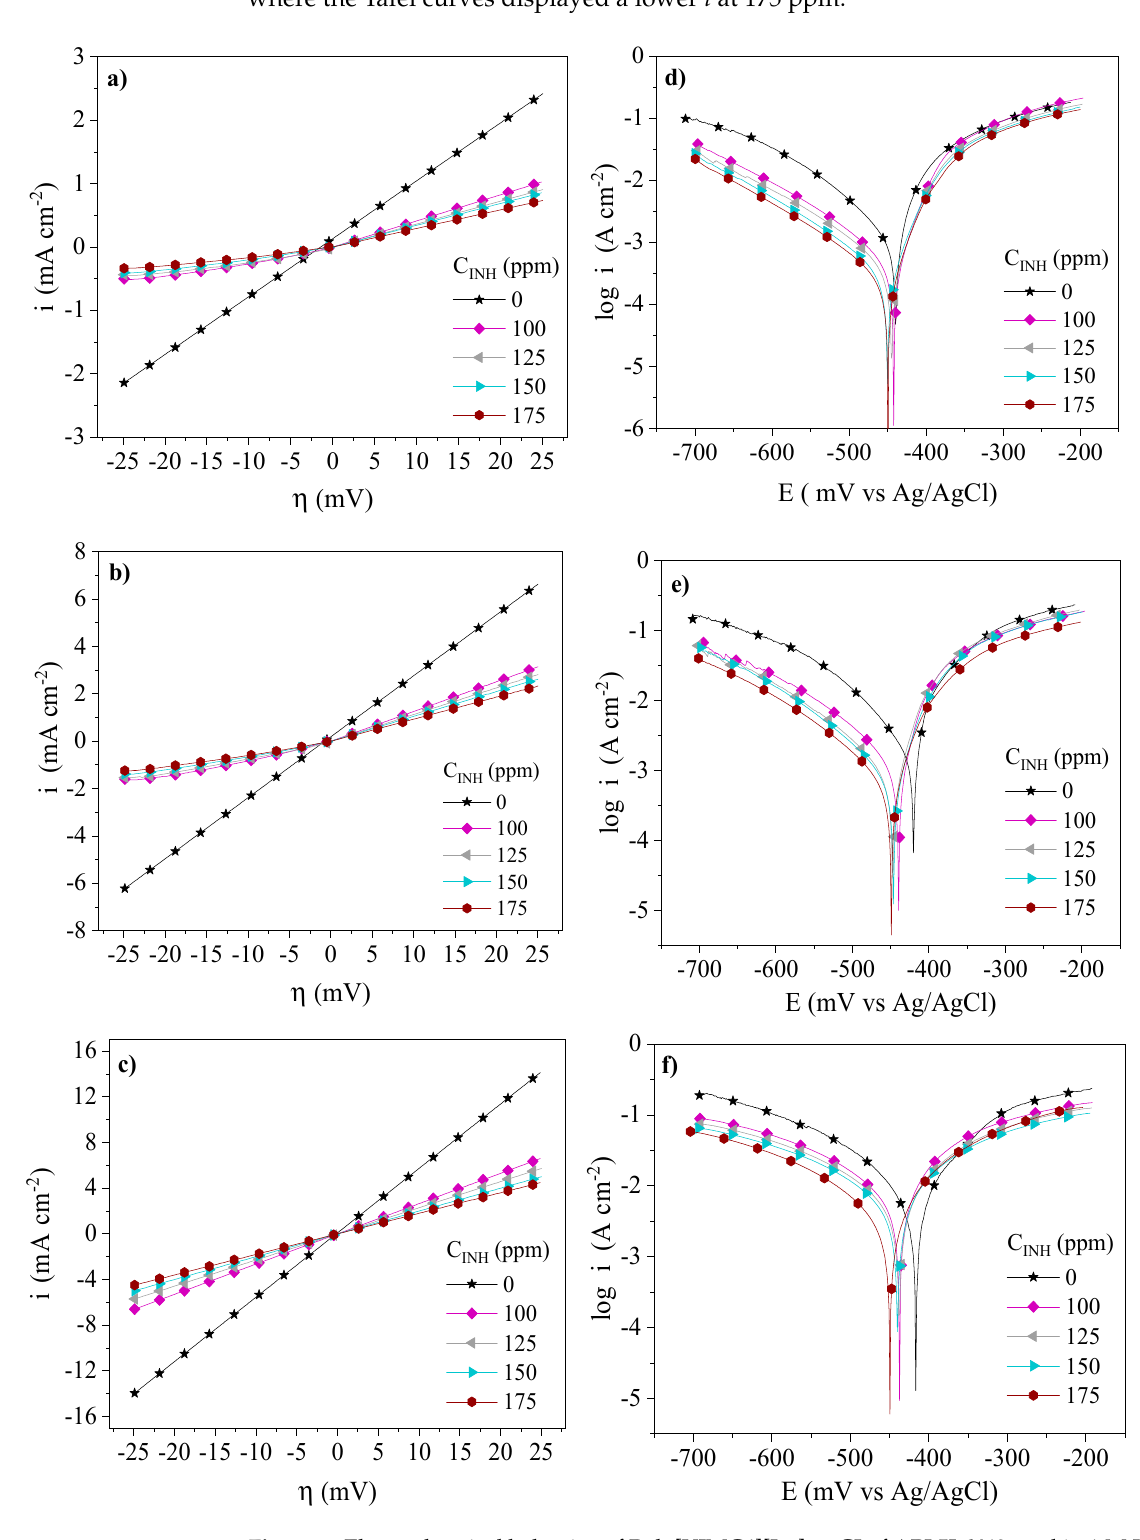
Figure 3. Electrochemical behavior of Poly[VIMC4][Im] as CI of API 5L X60 steel in 1 M H 2 SO 4 by the LPR and PDP techniques: ( a ) LPR – 308 K, ( b ) LPR – 318 K, ( c ) LPR – 328 K, ( d ) PDP – 308 K, ( e ) PDP – 318 K and ( f ) PDP – 328 K.